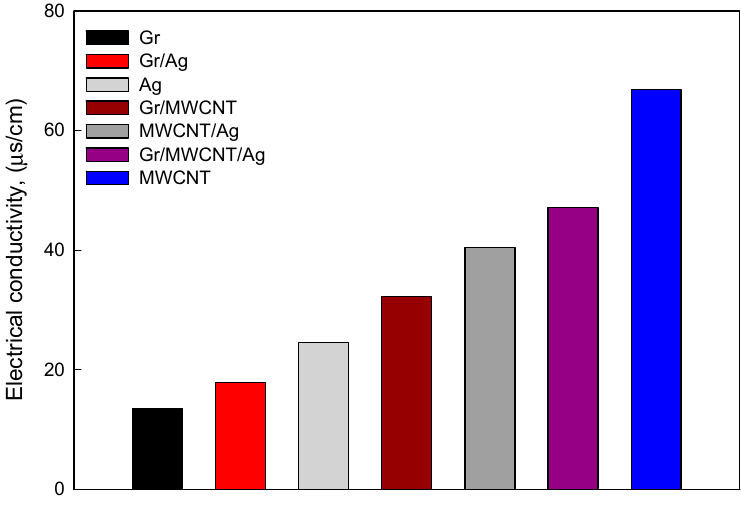
Figure 8. Electrical conductivities of the nanofluids (0.1 wt.%).